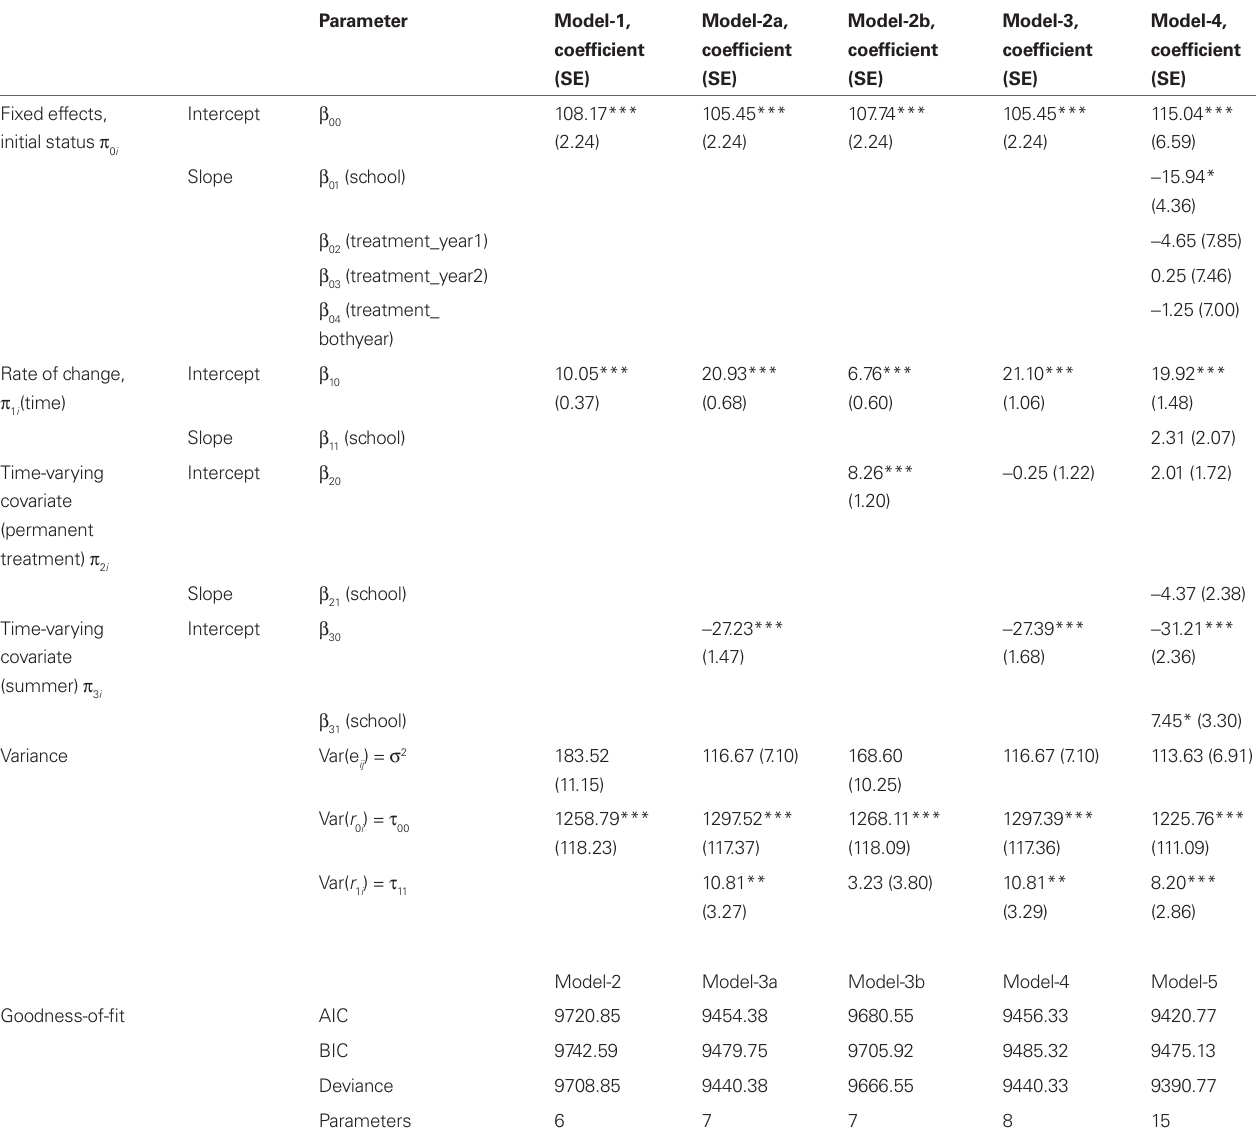
Table 5 | Parameter estimates for the five growth